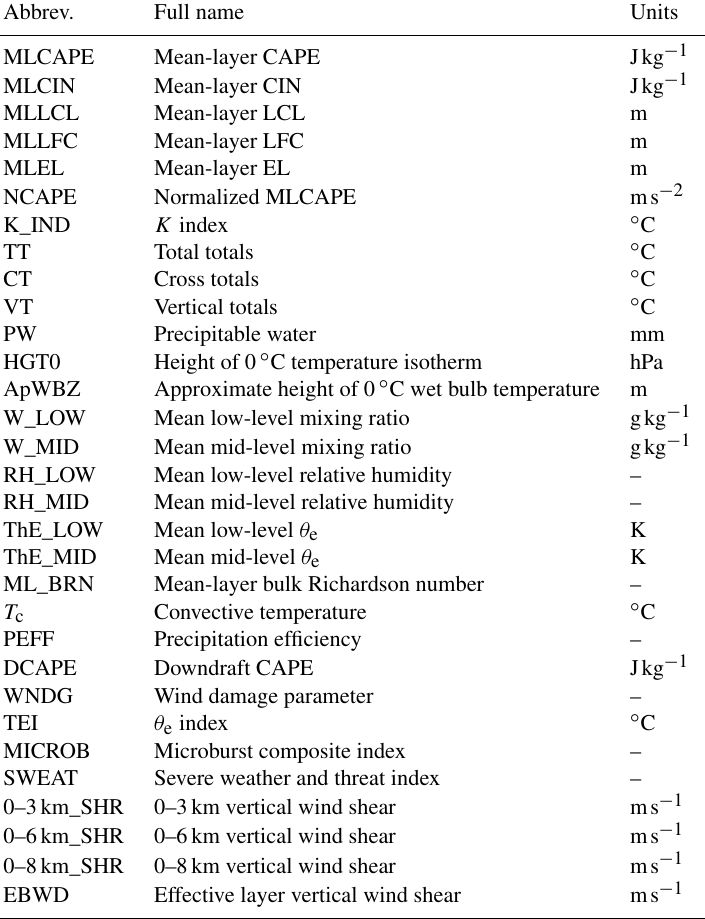
Table 2. List of the 31 convective parameters computed from the proxy soundings where CAPE, CIN, LCL, LFC, and EL and correspond to convective available potential energy, convective inhibition, lifted condensation level, level of free convection, and equilibrium level,